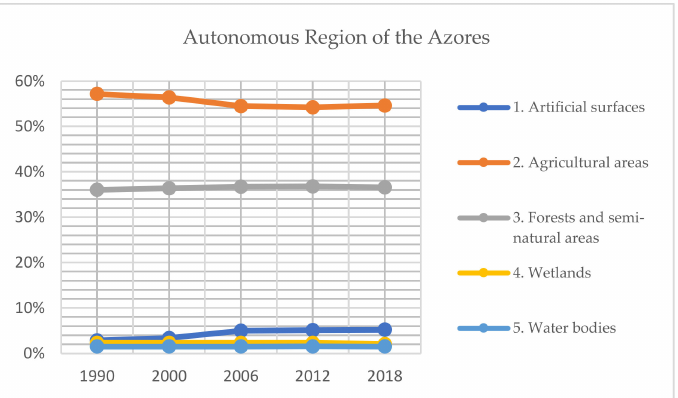
Figure 5. Percentage of land-uses according to level 1 of CLC nomenclature in the Autonomous Region of the Azores.